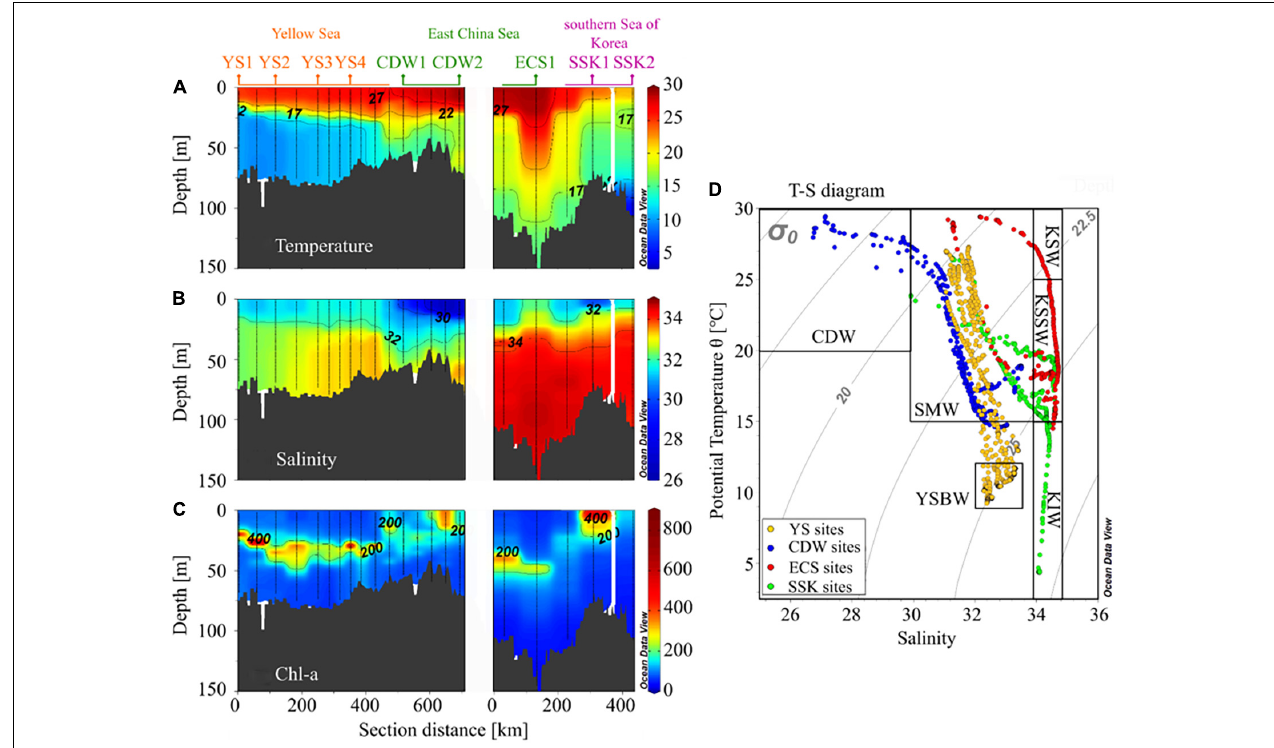
FIGURE 2 | Distributions of (A) temperature ( ◦ C), (B) salinity, (C) chlorophyll- a (ng L − 1 ), and (D) temperature-salinity (T-S) diagrams in the study region. Water masses are also indicated on the T-S diagram: CDW, KSW, KSSW, SMW, YSBW, and KIW refer to Changjiang Diluted Water, Kuroshio Surface Water, Kuroshio Subsurface Water, Shelf Mixed Water, Yellow Sea Bottom Cold Water, and Kuroshio Intermediate Water, respectively.